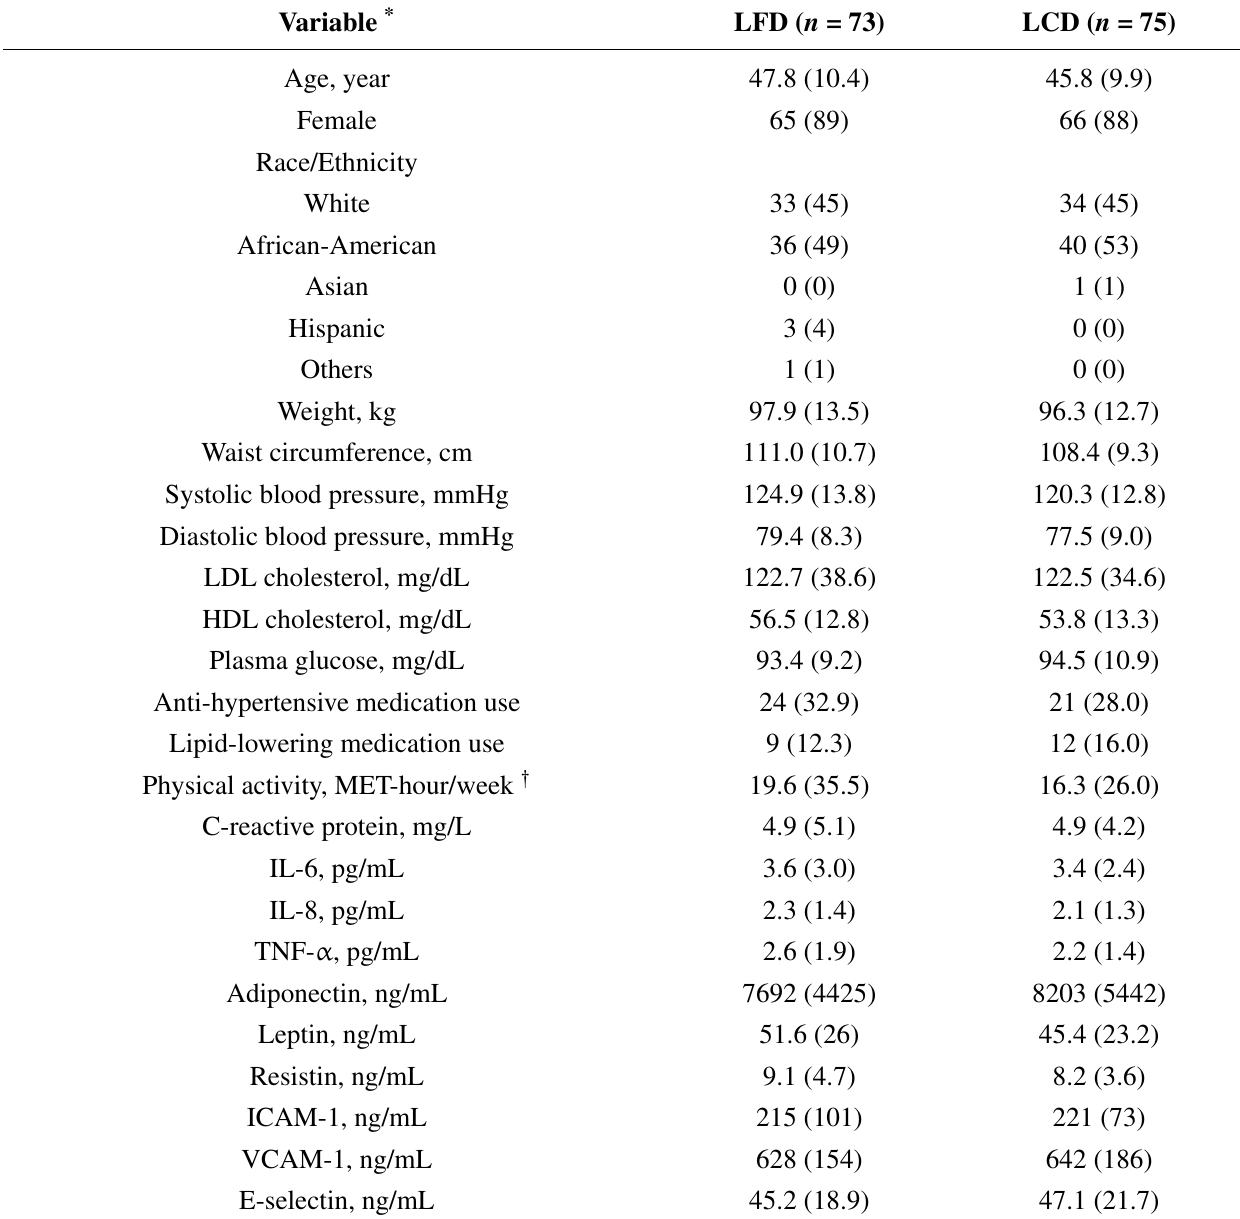
Table 1. Baseline characteristics of trial